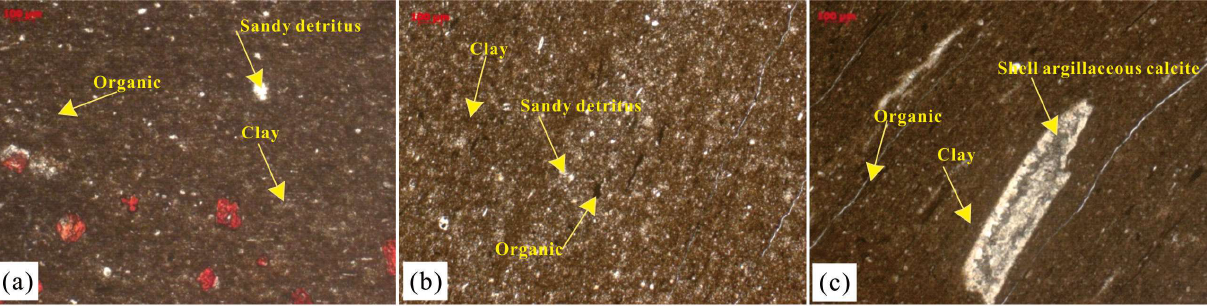
Figure 4. Microscopic photos of continental shale: ( a ) High-carbon clayey shale. ( b ) Medium-carbon calcareous clayey shale. ( c ) Medium-carbon clayey shale. ( d ) Medium-carbon clayey shale. ( e ) Me- dium-carbon clayey shale. ( f ) Medium-carbon clayey shell calcareous shale. 4.1.2. Mineral Fabric Characteristics The ECS element logging data (Figure 5a) and the results of the whole-rock mineral X-ray diffraction analysis (Figure 5b) showed that the mineral components of continental shale in the Yuanba Area mainly included clay minerals and quar(cid:309), followed by calcite and a small quantity of feldspar and mica. The clay mineral content ( n = 46) ranged from 21.54% to 68.3% with an average of 48.29%. The total content of quar(cid:309) and feldspar ranged from 17.1% to 60.3% with an average of 35.69%. The carbonate mineral content ranged from 0 to 48.8% with an average of 12.57%. In general, the contents of clay mineral and quar(cid:309) were high and carbonate minerals were locally enriched. Continental shale in the Yuanba and Fuling Areas was deposited in shallow and semi-deep lake environments of carbonate rocks (Figure 1). Compared with the marine shale of the Wufeng Formation– Longmaxi Formation (Figure 6a), the continental shale of the Da’anzhai Member had the lower content of siliceous minerals and the highest content of carbonate minerals (Figure 6b). The drilling data and rock slice identification results indicated that the enrichment of carbonate minerals in the continental shale layer was ascribed to the existence of a large number of local shell limestone interlayers. The minerals in the shell limestone mainly included argillaceous calcite, bright calcite, argillaceous, and a large number of developed microfractures (Figure 7).